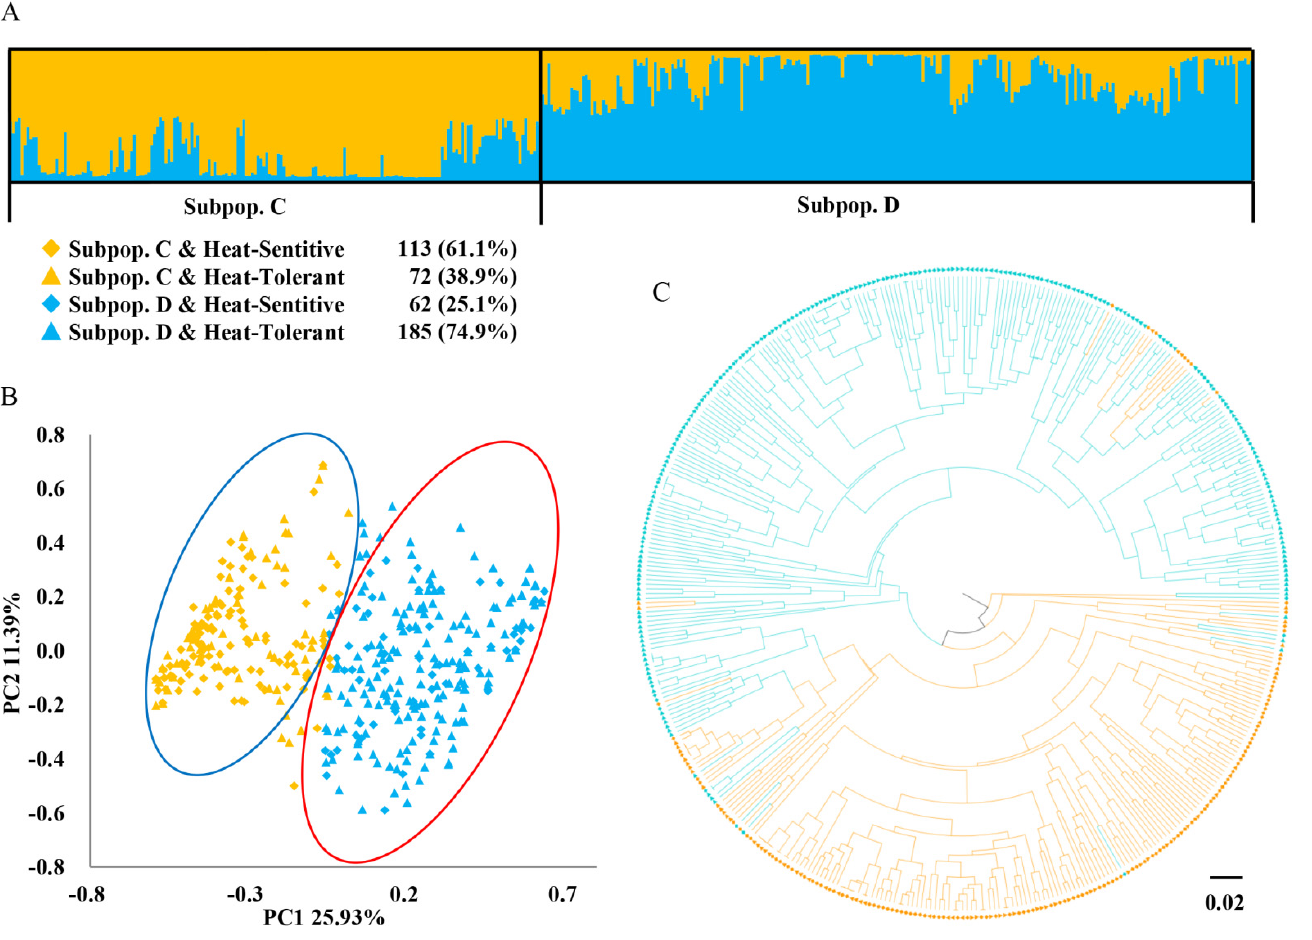
Figure 7. Population genetic structure of 432 pea accessions after HTS1 using heat-tolerance-related SNaPshot markers. ( A ) Structure analysis with 20 heat-tolerance-related SNaPshot markers. ( B ) PCoA with 20 heat-tolerance-related SNaPshot markers: the orange diamonds represent the SS type of Subpopulation C and the orange triangles represent the WS type of Subpopulation C; the light blue diamonds represent the SS type of Subpopulation D and the light blue triangles represent the WS type of Subpopulation D. ( C ) UPGMA tree based on Nei’s genetic distance with 20 heat-tolerance-related SNaPshot markers.